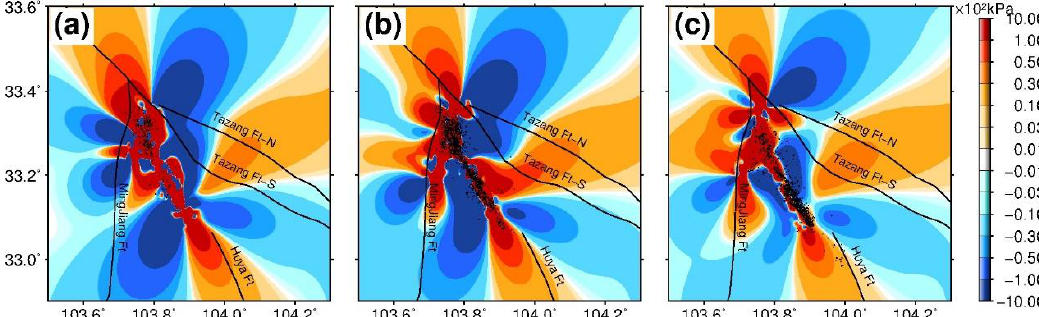
Figure 9. Static Coulomb stress changes on the 3D optimally oriented failure planes created by the Jiuzhaigou earthquake at different depths and the distribution of the aftershocks within 5 km. Coulomb stress changes at a depth of ( a ) 5 km, ( b ) 10 km, and ( c ) 15 km. Black dots represent the relocated aftershocks.